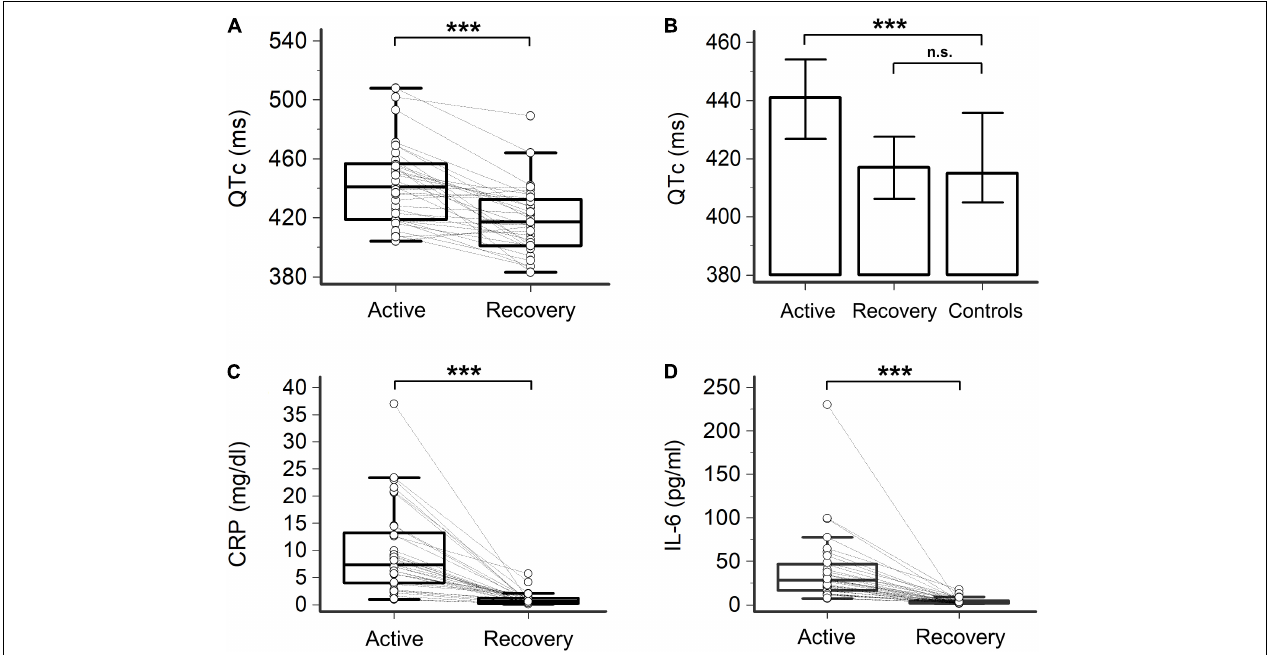
FIGURE 1 | Heart rate-corrected QT interval (QTc), C-reactive protein (CRP), and interleukin-6 (IL-6) in patients with COVID-19, during active disease and recovery. (A) Heart rate-corrected QT interval based on Bazett’s formula (QTc); two-tail paired t -test, *** p < 0.001. (B) Comparison of QTc in patients with COVID-19, during active disease and recovery, and controls; two-tailed unpaired t -test, *** p < 0.001, n.s. not significant. (C) CRP; two-tailed paired t -test, *** p < 0.0001. (D) IL-6; two-tailed Wilcoxon matched pairs test, *** p < 0.001. Patients, n = 33; controls, n =